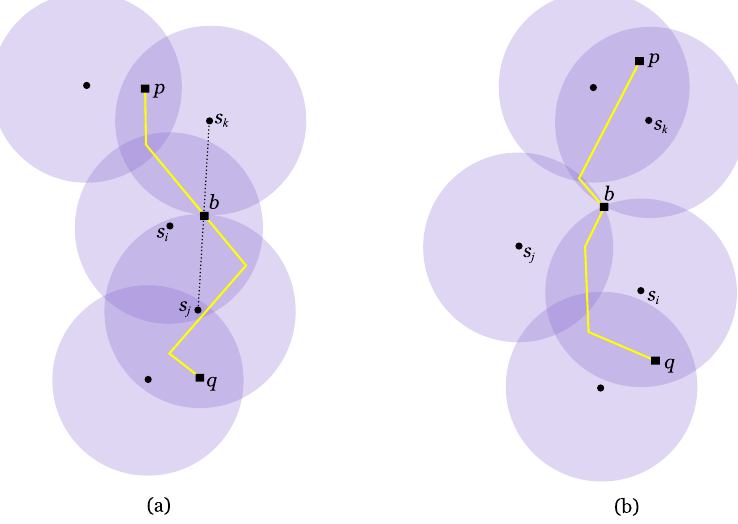
Figure 11. he antennas’ range is r = MR in yellow. (a) Point b = b II